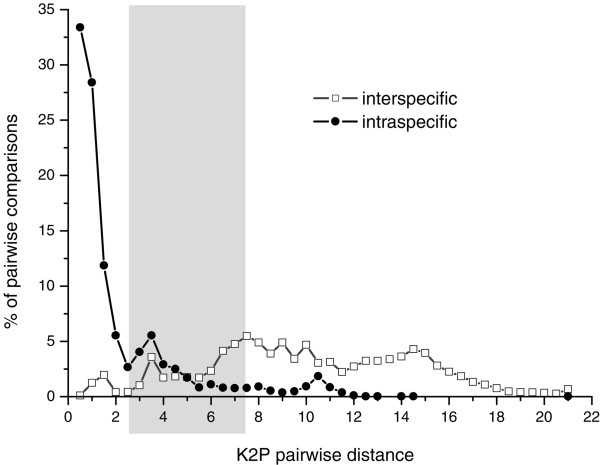
Distance analysis. Distributions of interspecific (white squares) and intraspecific (black circles) pairwise K2P distances resulting from the analysis of 15,948 DNA barcodes belonging to 1,995 insect species (dataset A). In grey: overlap between the 95% percentiles of intra- and interspecific distributions (2.47%<K2P < 7.64%).